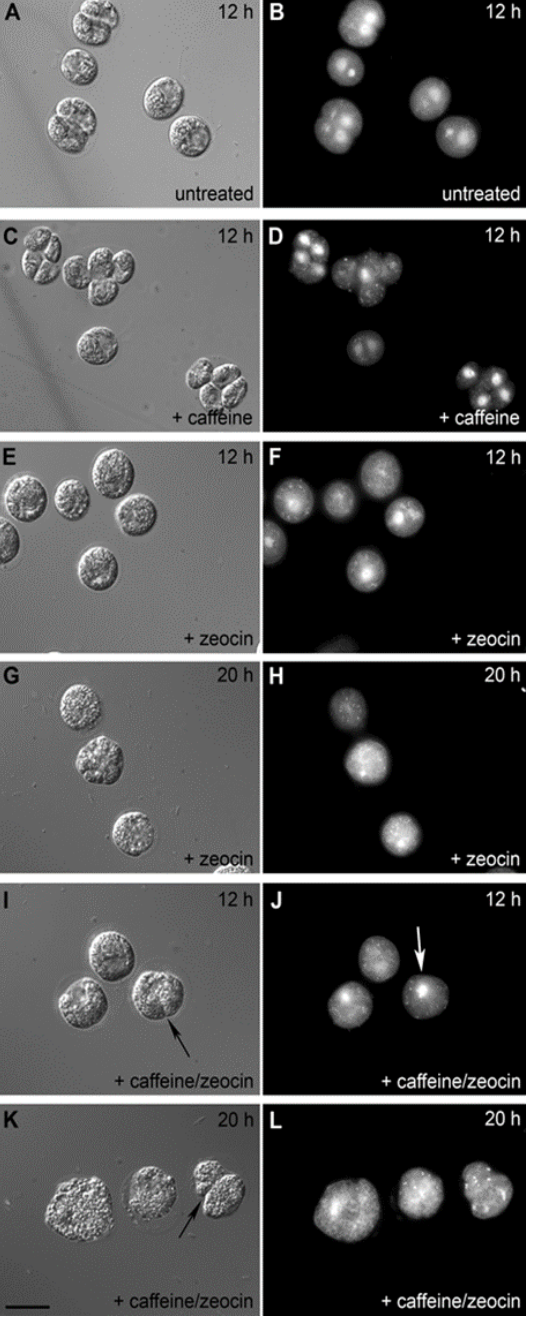
Figure 5. Photomicrographs of untreated ( A , B ), ca ff eine-treated ( C , D ), zeocin-treated ( E – H ) and ca ff eine / zeocin-treated ( I – L ) C. reinhardtii cells from the 13th hour of the synchronized cell cycle. Cells in transmitted light (A, C, E, G, I, K), fluorescence photomicrographs (B, D, F, H, J, L) of cells with nuclei stained by SYBR Green I dye. Bar = 10 µ m (all photomicrographs). The untreated and ca ff eine-treated cells divide their nuclei and cells; zeocin and ca ff eine / zeocin-treated cells stay uni-nuclear, the ca ff eine / zeocin-treated cells attempt to proceed with aberrant cell division (black arrow) in the absence of nuclear division (white